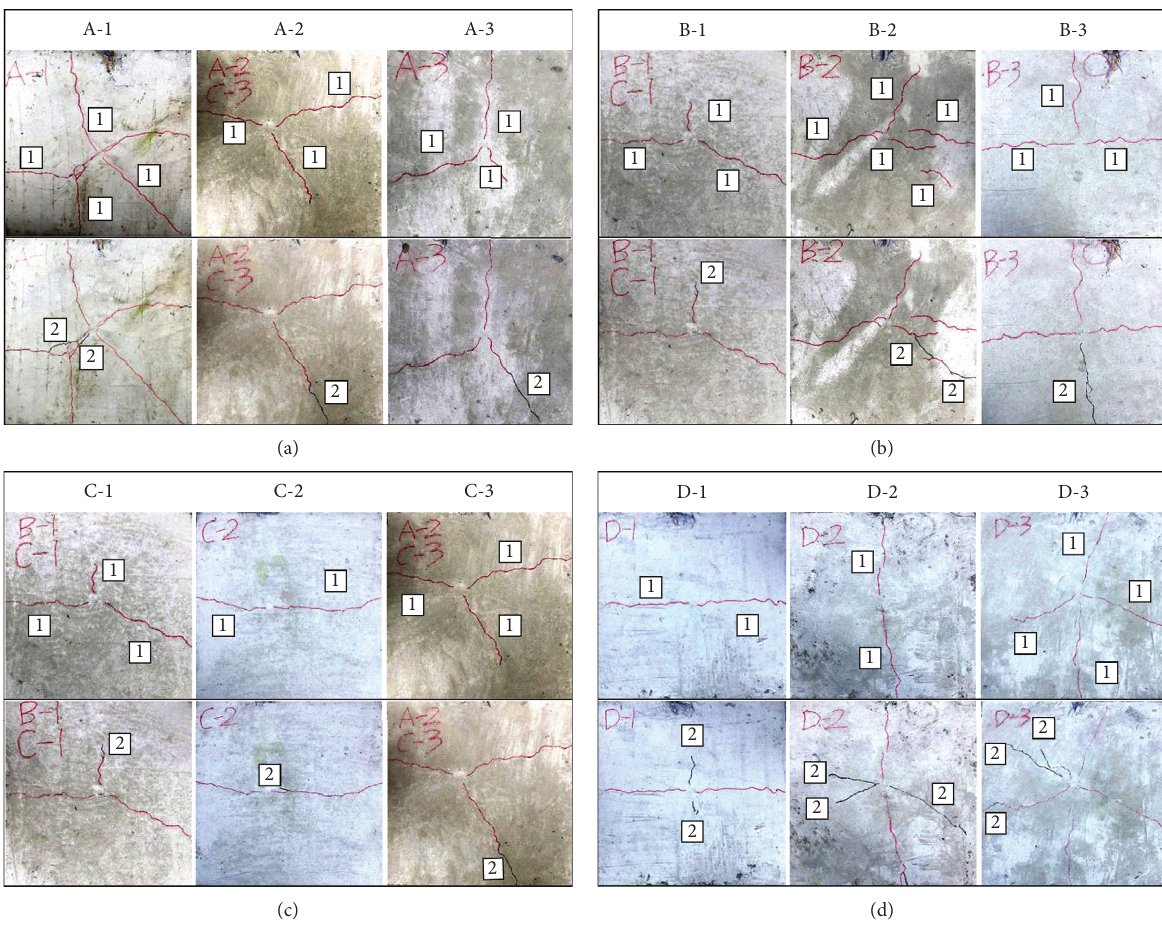
Figure 6: Surface damage of